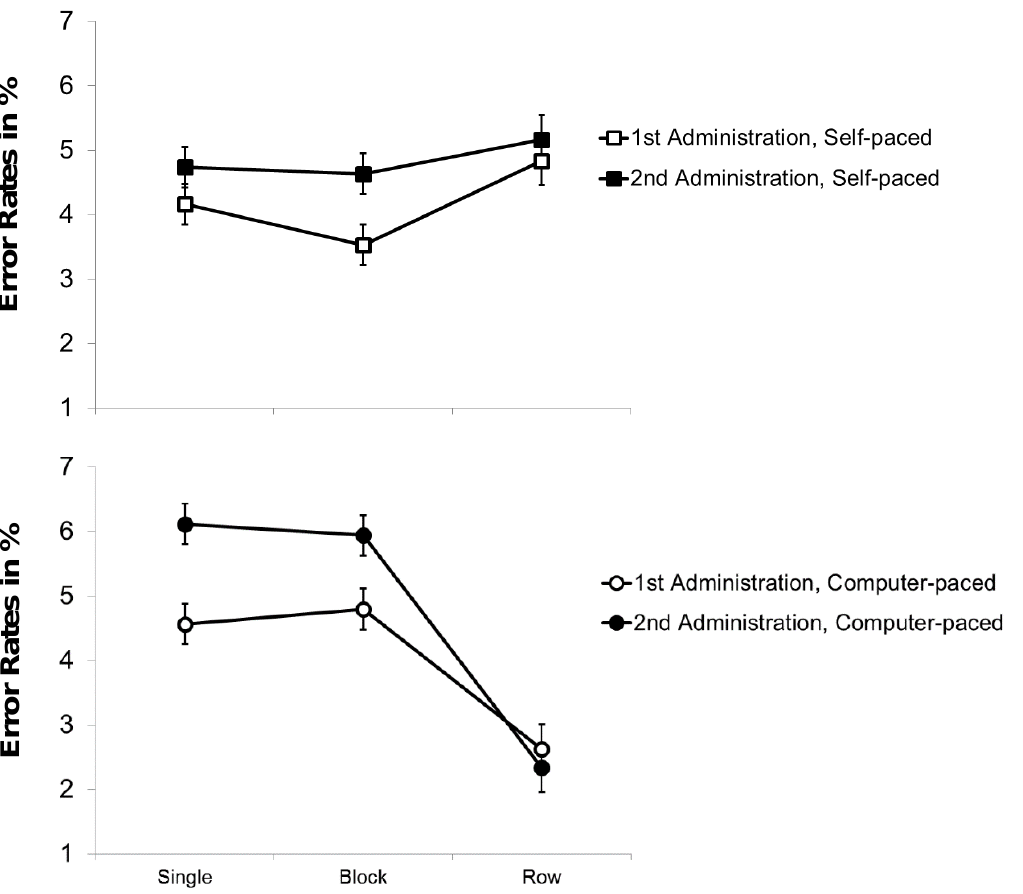
Figure 3. Mean error rates (in%) of the modified d2 as a function of stimulus arrangement (single versus blocks versus rows of stimuli) and pace (self-paced versus force-paced) for the first and second administration. Bars represent standard errors.